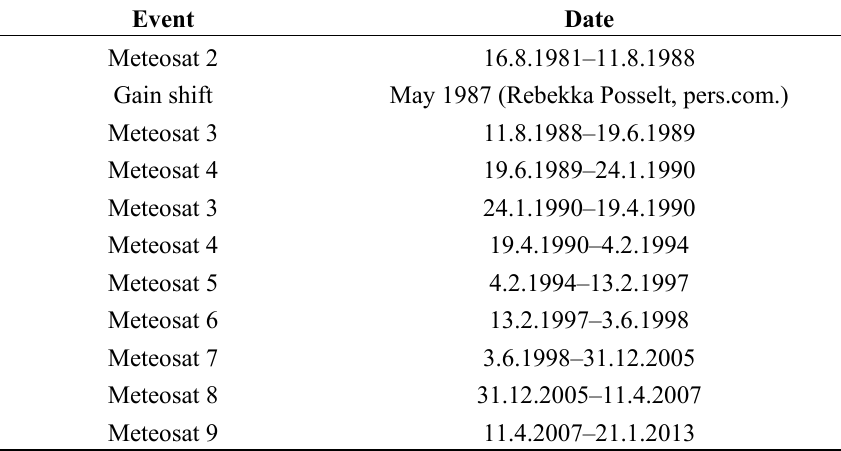
Table 2. History of the Meteosat satellites used to derive CM SAF SIS and other major events.